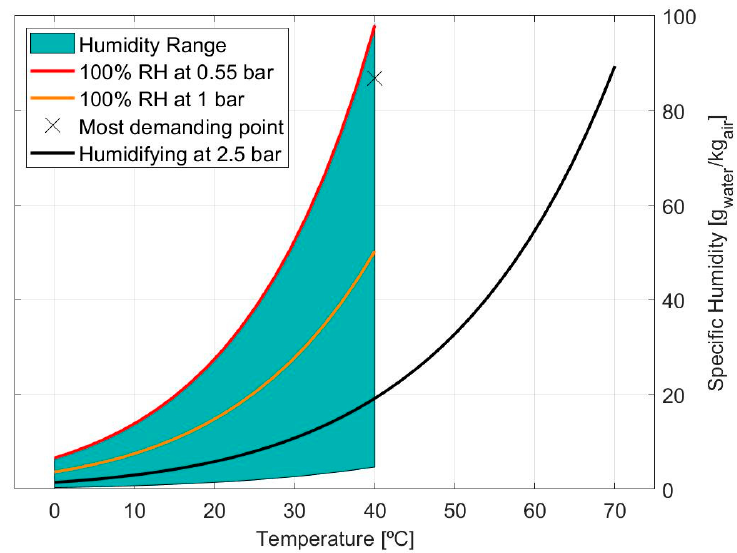
Appl. Sci. 2021 , 11 , x FOR PEER REVIEW Figure 1. Psychometric conditions for the humectant process. Figure 1. Psychometric conditions for the humectant process.